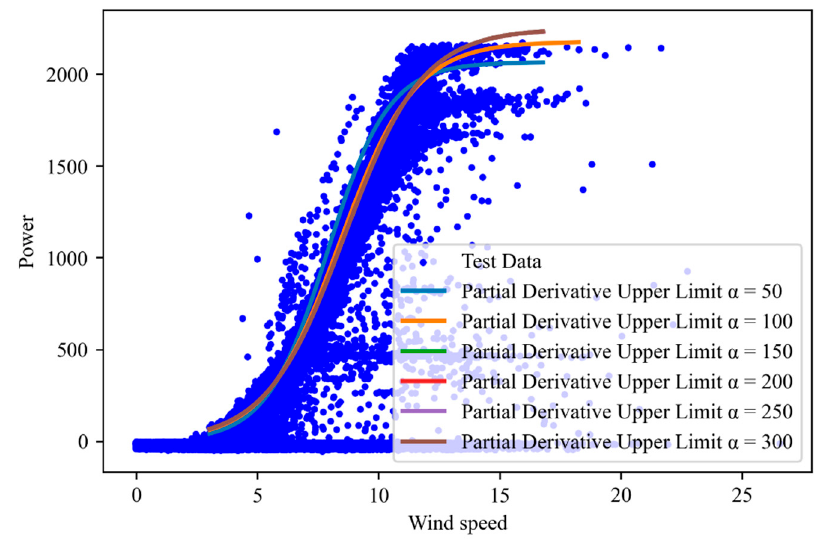
Figure 10. The results of quadratic fitting of the cleaned data under different partial derivative upper limit α values.